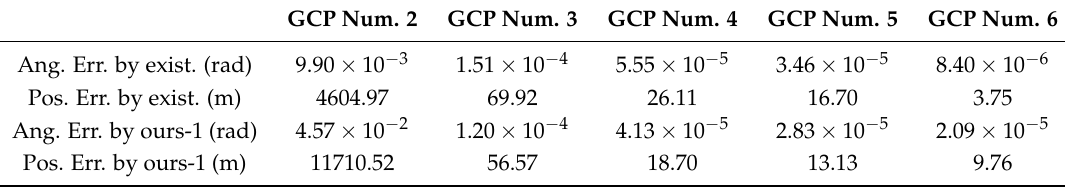
Table 2. Error of estimated Exterior orientation parameters’ (EOPs) with different numbers of GCPs based on error-free data. Here, “GCP Num.” indicates the number of ground control points; “Ang. Err.” indicates the error of angular rotation; “Pos. Err.” indicates the error of spatial position. When the number of GCPs is ≥ 3, all GCPs should not lie in a single straight line. GCP Num.